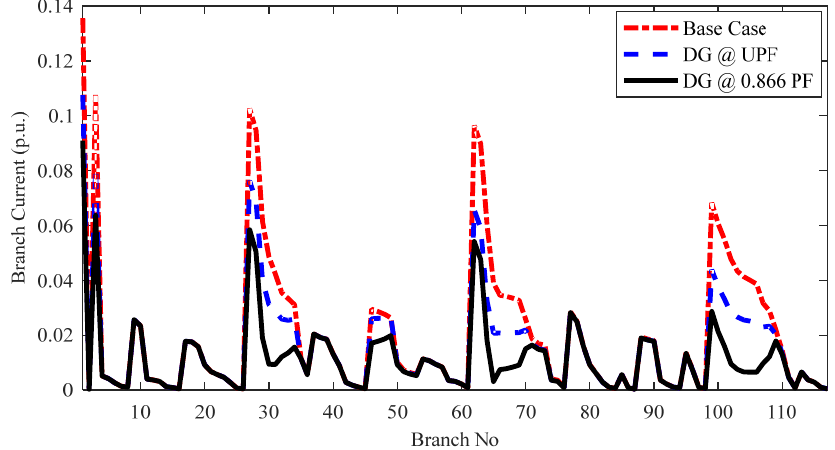
Figure 12. Voltage profile of the 118 bus test system for scenario IV.